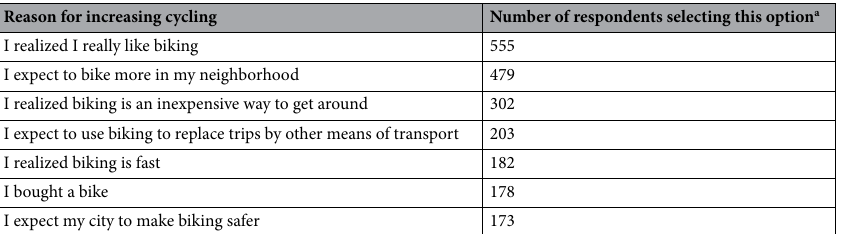
Table 2. Reasons for the intended increase in cycling post COVID-19 pandemic (n = 1002). a Multiple responses per individual were